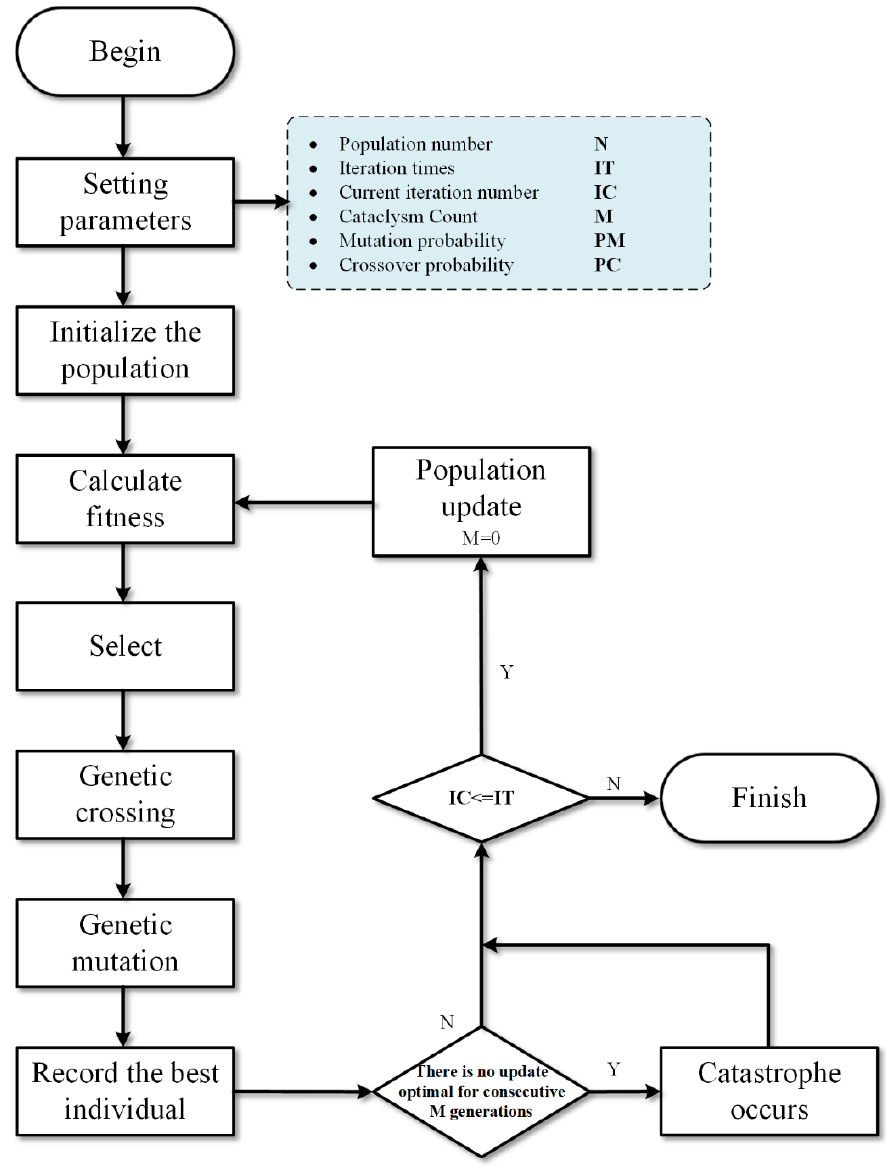
Figure 4. Genetic algorithm flow chart.